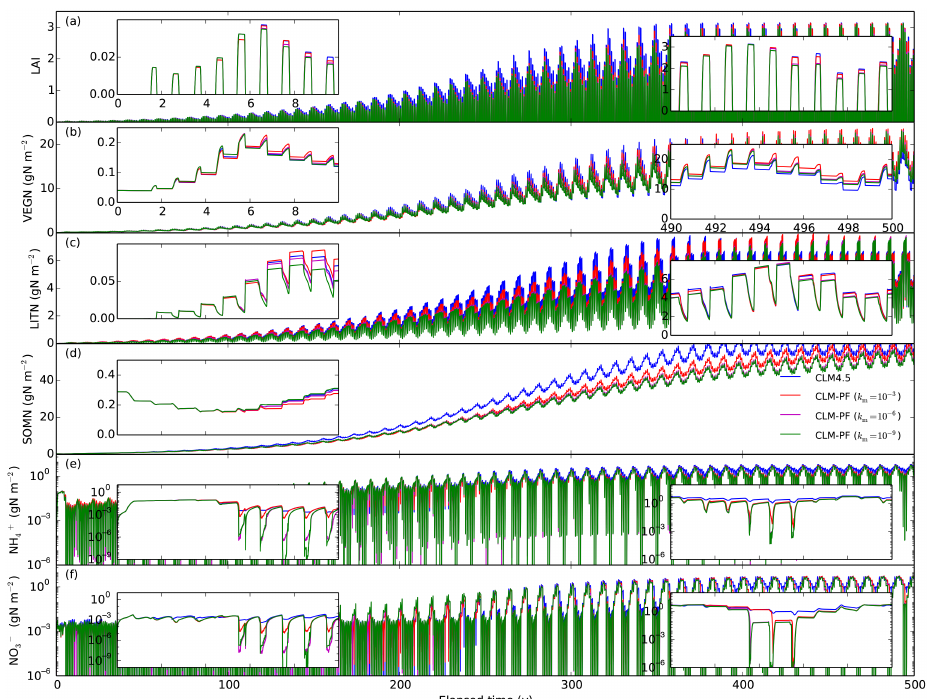
, and NO − pools in spin-up simulations for the 4 3